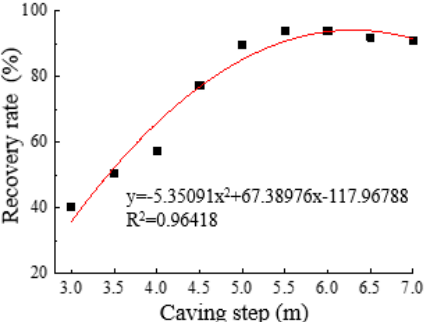
Figure 11. Relationship between ore recovery ratio and caving step.